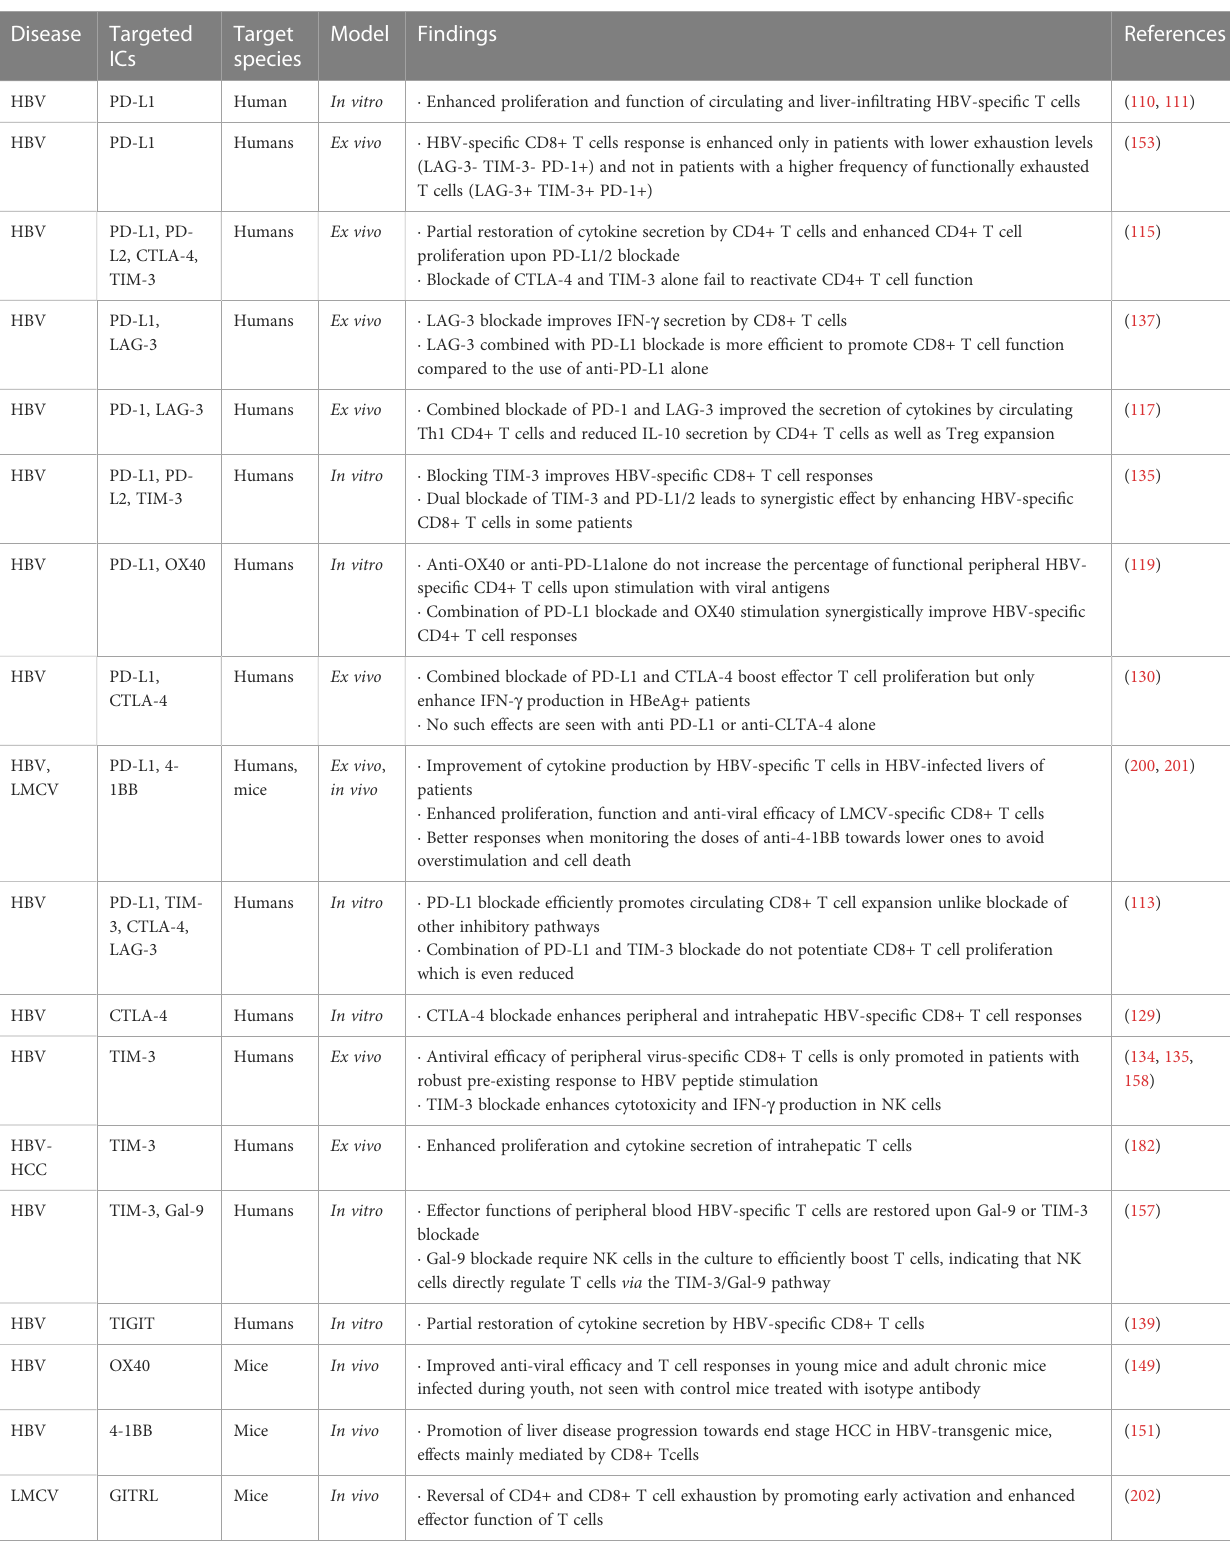
TABLE 2 Effects of immune checkpoint blockade on effector immune cells in chronic HBV infection and related diseases.